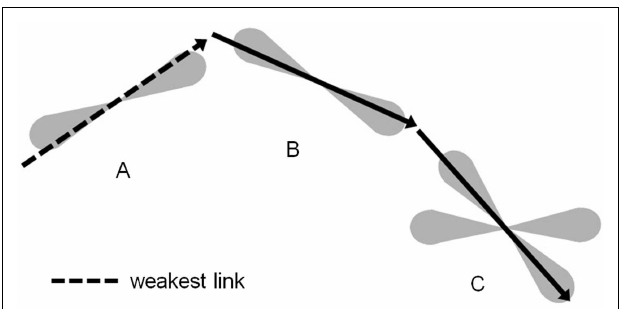
FIGURE 3 |The tractography process propagates streamlines iteratively with the direction of propagation chosen from within the PDF for the direction of fiber propagation .The confidence in this tract segment generated is given by the scaled value of the PDF for the fiber orientation in the direction propagated.The confidence value for a streamline connecting voxel C to voxel A is given by the lowest confidence value for all segments along that streamline. Here, the dashed tract segment, which runs along the edge of the PDF, has the lowest confidence.The scalar connectivity index for connection of voxel C to reference voxel A will be given by the maximal confidence value of all streamlines that connect the two